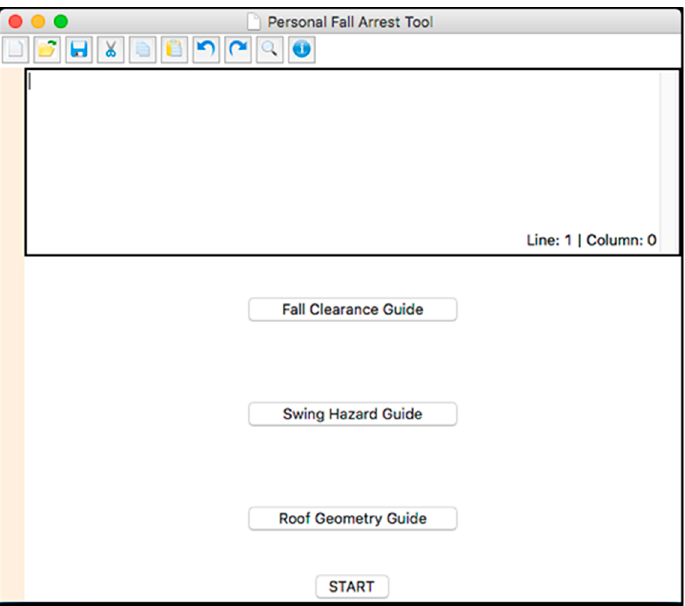
Figure 3. The PFAS tool’s main menu.